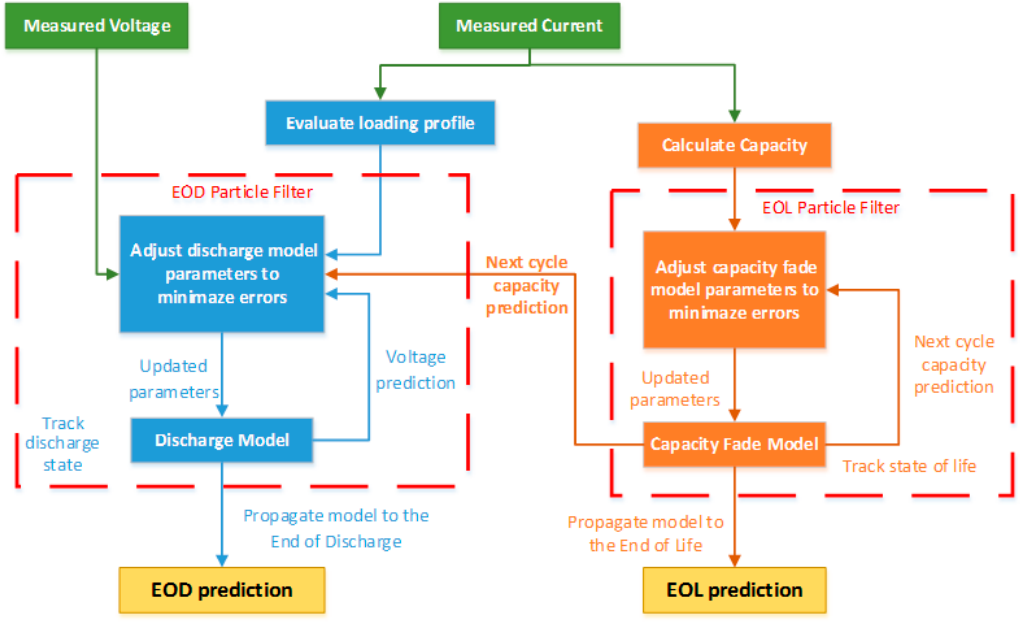
Figure 6. Diagnostic and prognostic framework.